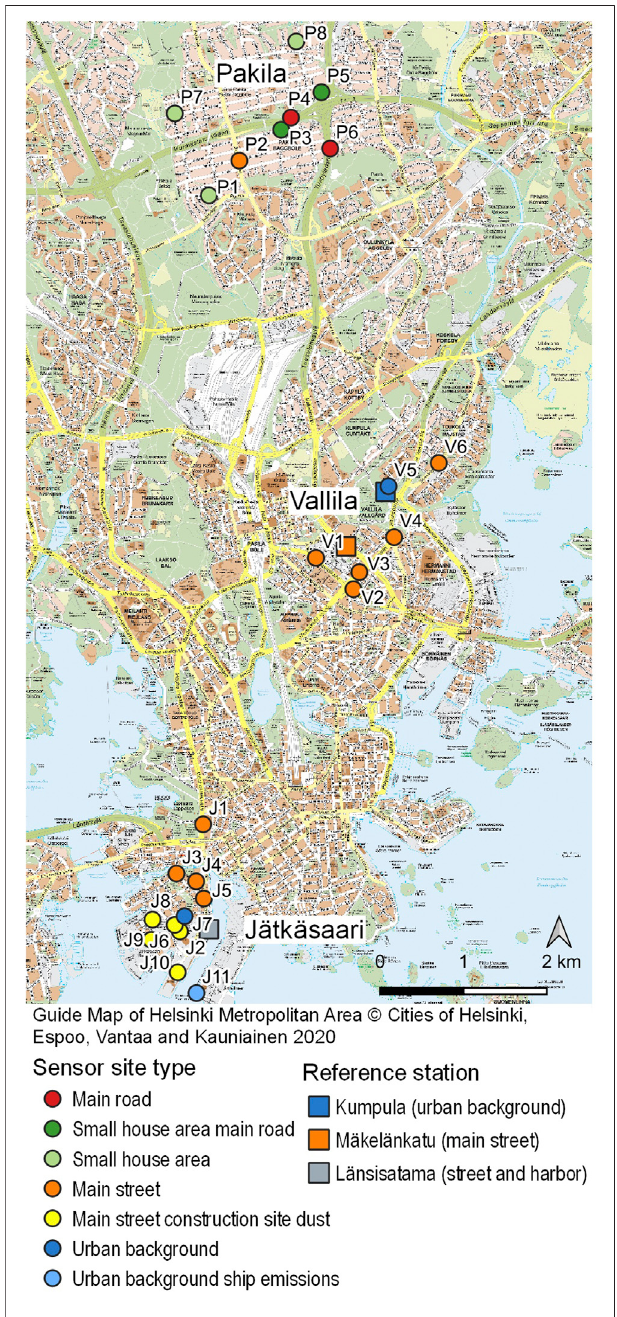
FIGURE 3 | A map of Helsinki area with the AQT530 sensor network sites in Jätkäsaari, Pakila and Vallila as well as the location of three reference air quality monitoring stations. The color codes show the sensor environment classi fi